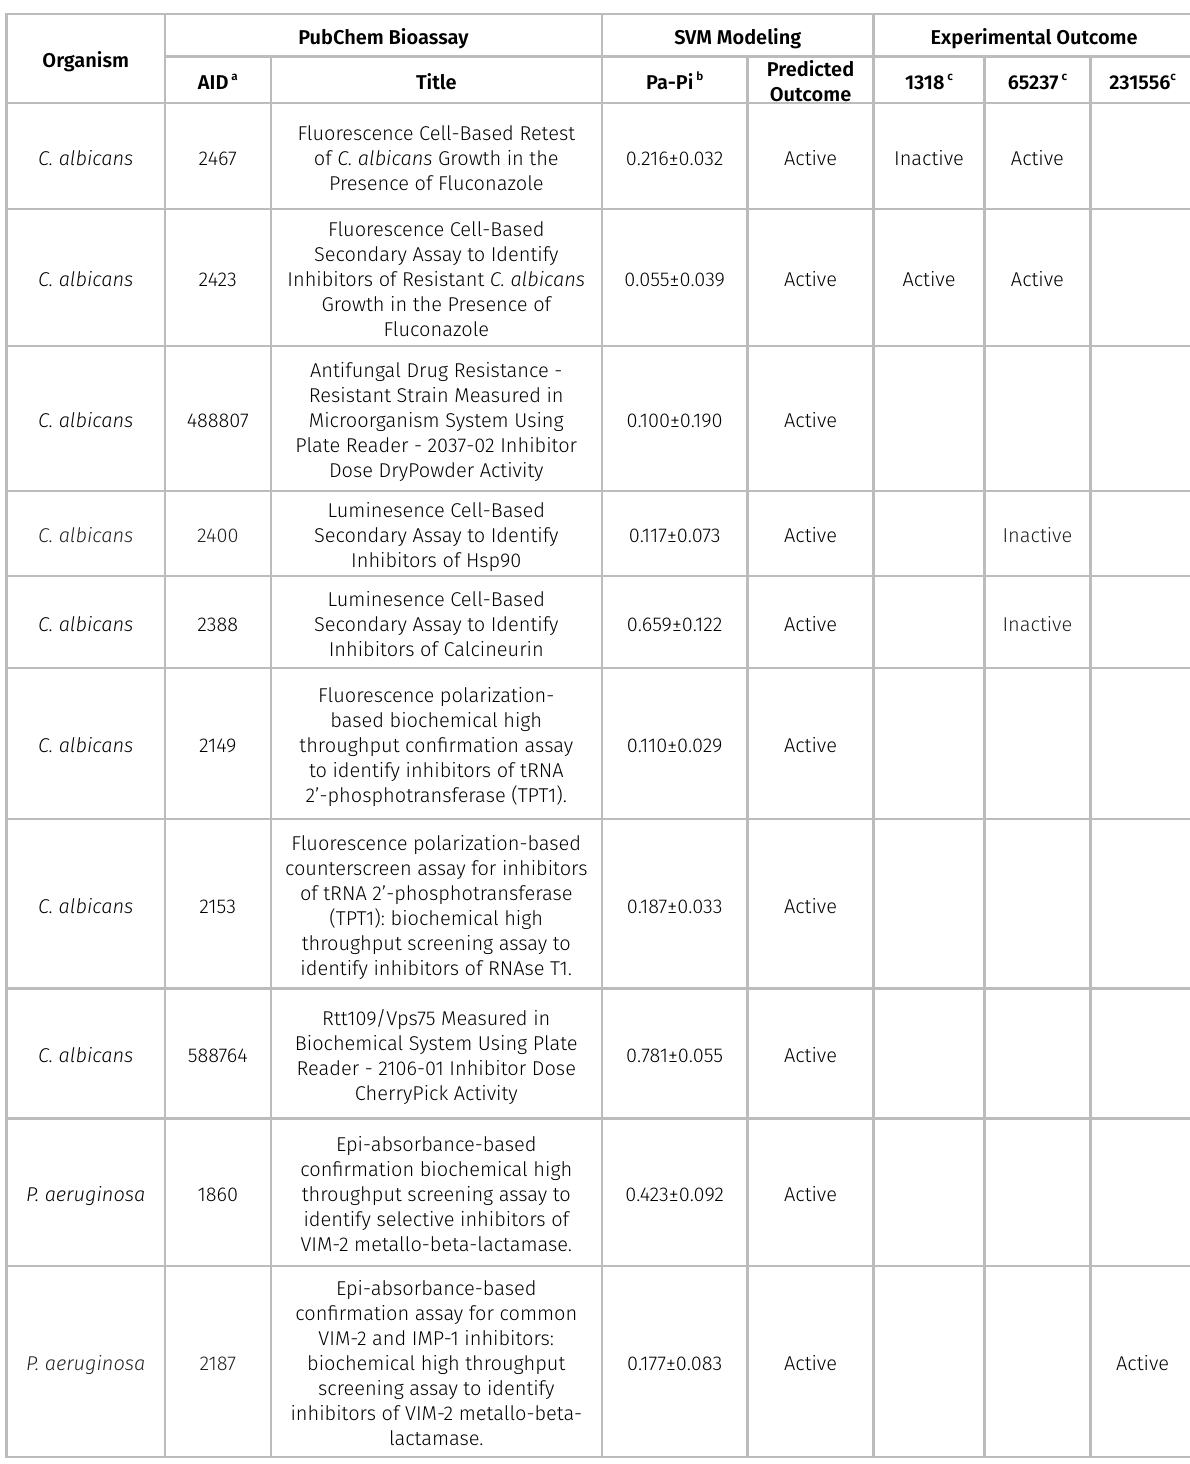
Table IV. Models were the 1,10-phenanthroline (AID=1318) was predicted to be active by SVM modeling. The Pa-Pi cutoff value of 0.05 was used to make the predictions. When available the experimental results for 1,10-phenanthroline (CID=1318), 2,9-Dimethyl-1,10-phenanthroline (CID=65237) and 7-methylquinolin-8-amine (CID=231556) were included for comparison